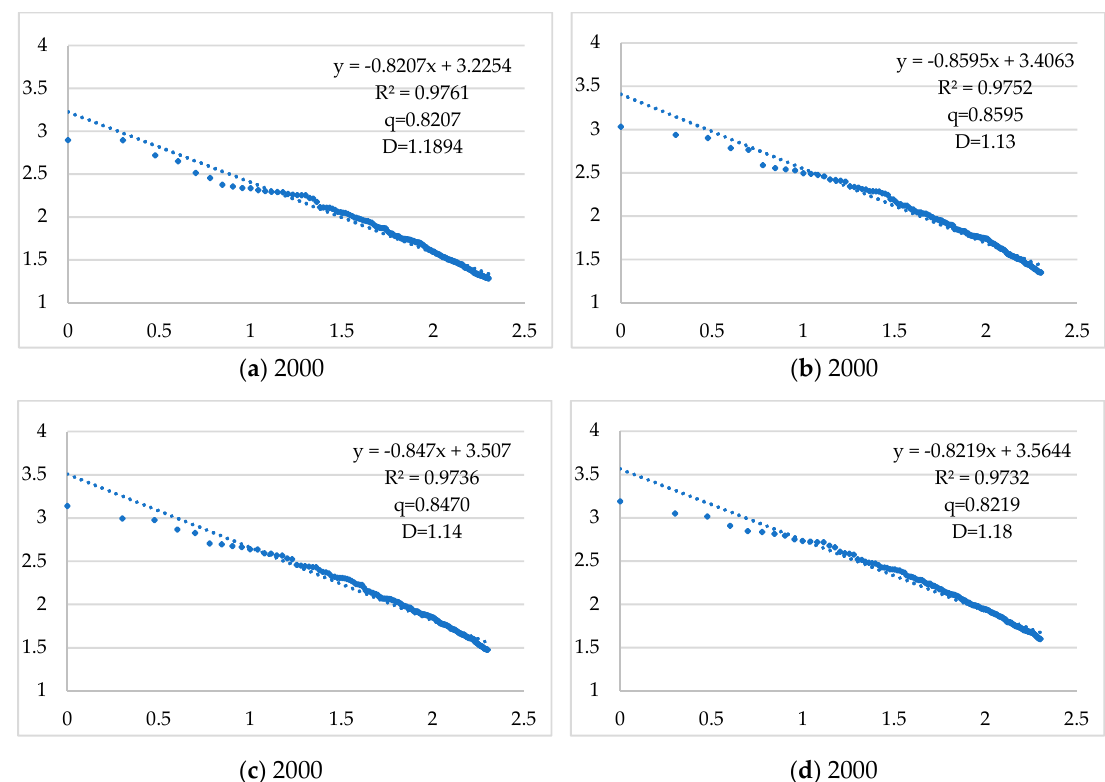
Figure 7. Cities' rank-size plots of China for 2000, 2005, 2010, 2015. The abscissa (x) is lg(R), where R stands for the city ranks of top200. The abscissa (x) is lg(R), where R stands for the city rank of top200. The vertical coordinates (y) is lg(S), where S stands for city size, namely urban area.